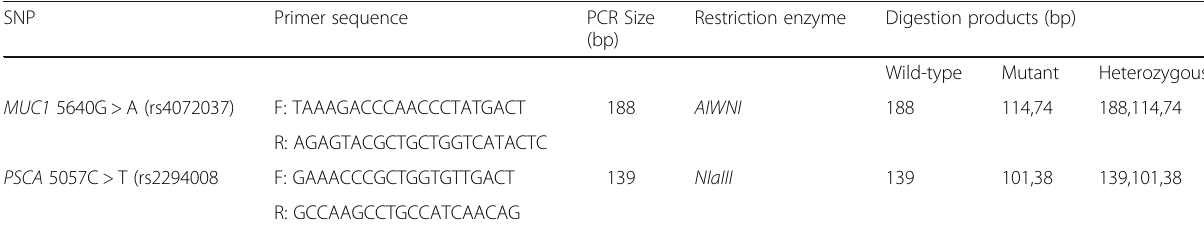
Table 3 Primer sequences, PCR size and PCR-RFLP fragments using AIWNI and NIaIII restriction enzymes for MUC1 5640G > A